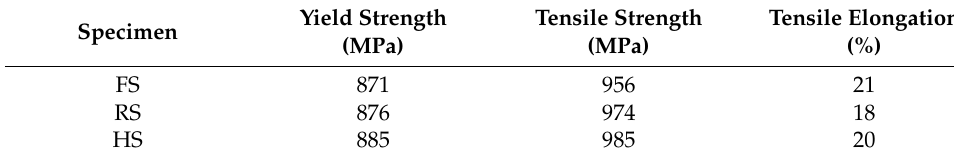
Yield Strength (MPa)